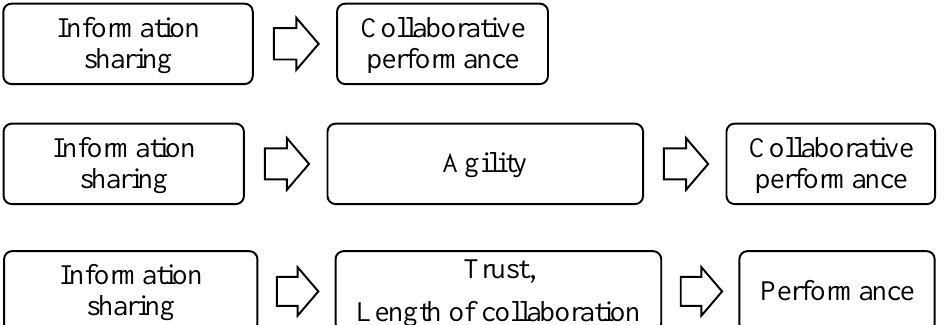
Figure 3. Causality between information sharing and performance based on different articles.